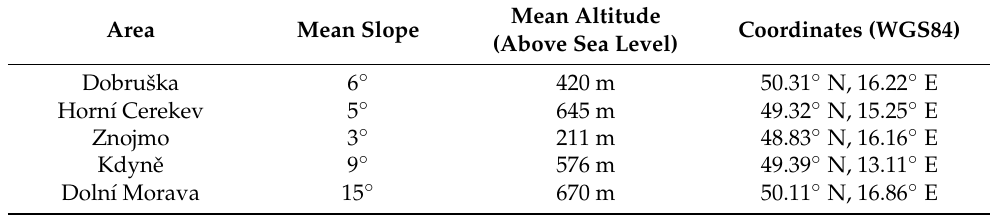
Table 2. Characteristics of the 5 selected locations (3 km × 3 km) for testing the elevation